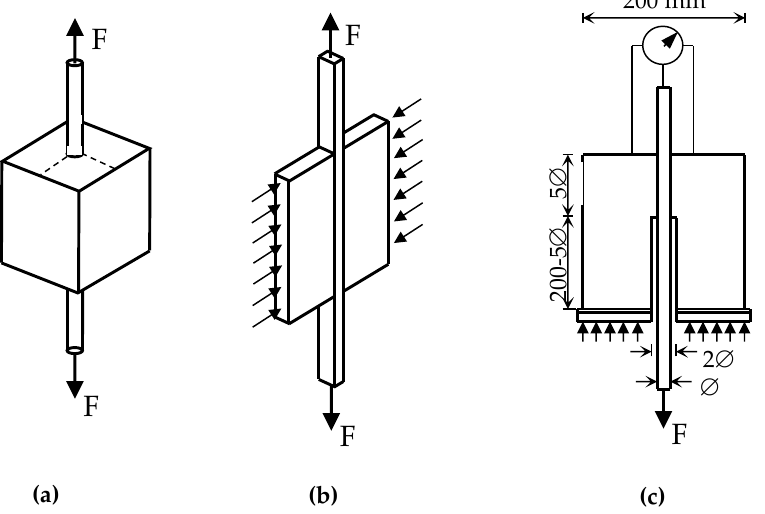
Figure 3. Setups for pull-out bond test. ( a ) Test for bond in tension. ( b ) Test for bond under transverse pressure. ( c ) Standardized pull-out test for bond.